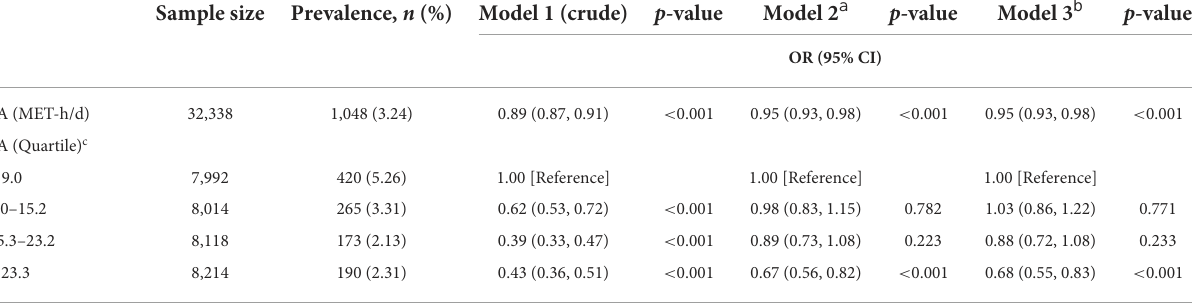
TABLE 2 Associations between total physical activity and the prevalence of MACE in all participants.